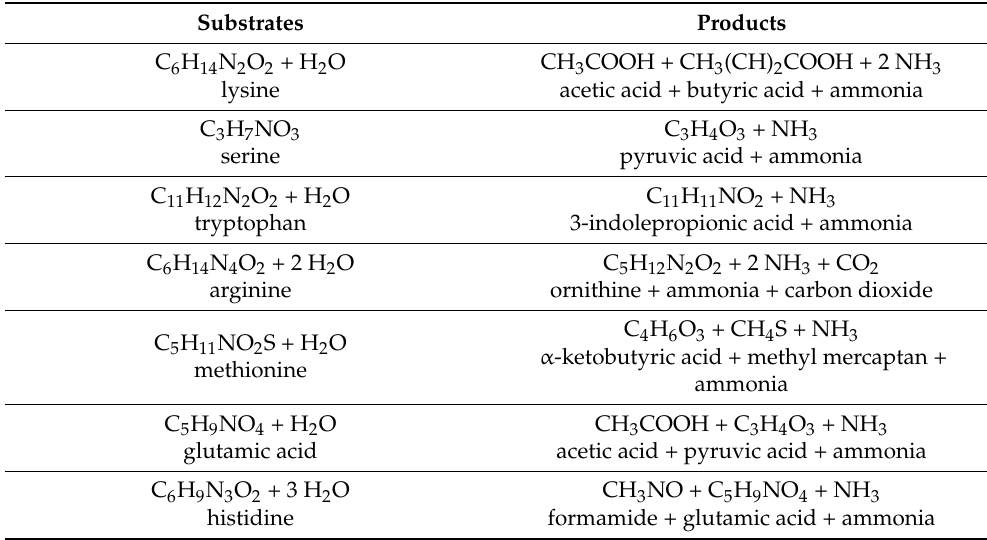
Table 3. Selected reactions of amino acid deamination by proteolytic bacteria of the genus Clostridium [34].